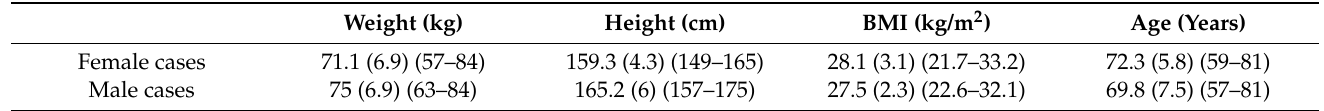
Table 1. Series descriptive data.